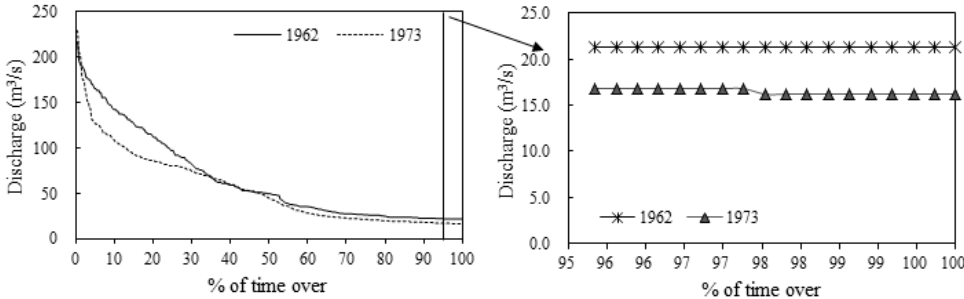
Figure 4. An example of flow duration curve for pair 1962 vs. 1973 in Phase 1 and Phase 2 (flow duration curves for other selected pairs in the moderation level of forest harvesting period can be found in Figure A1).